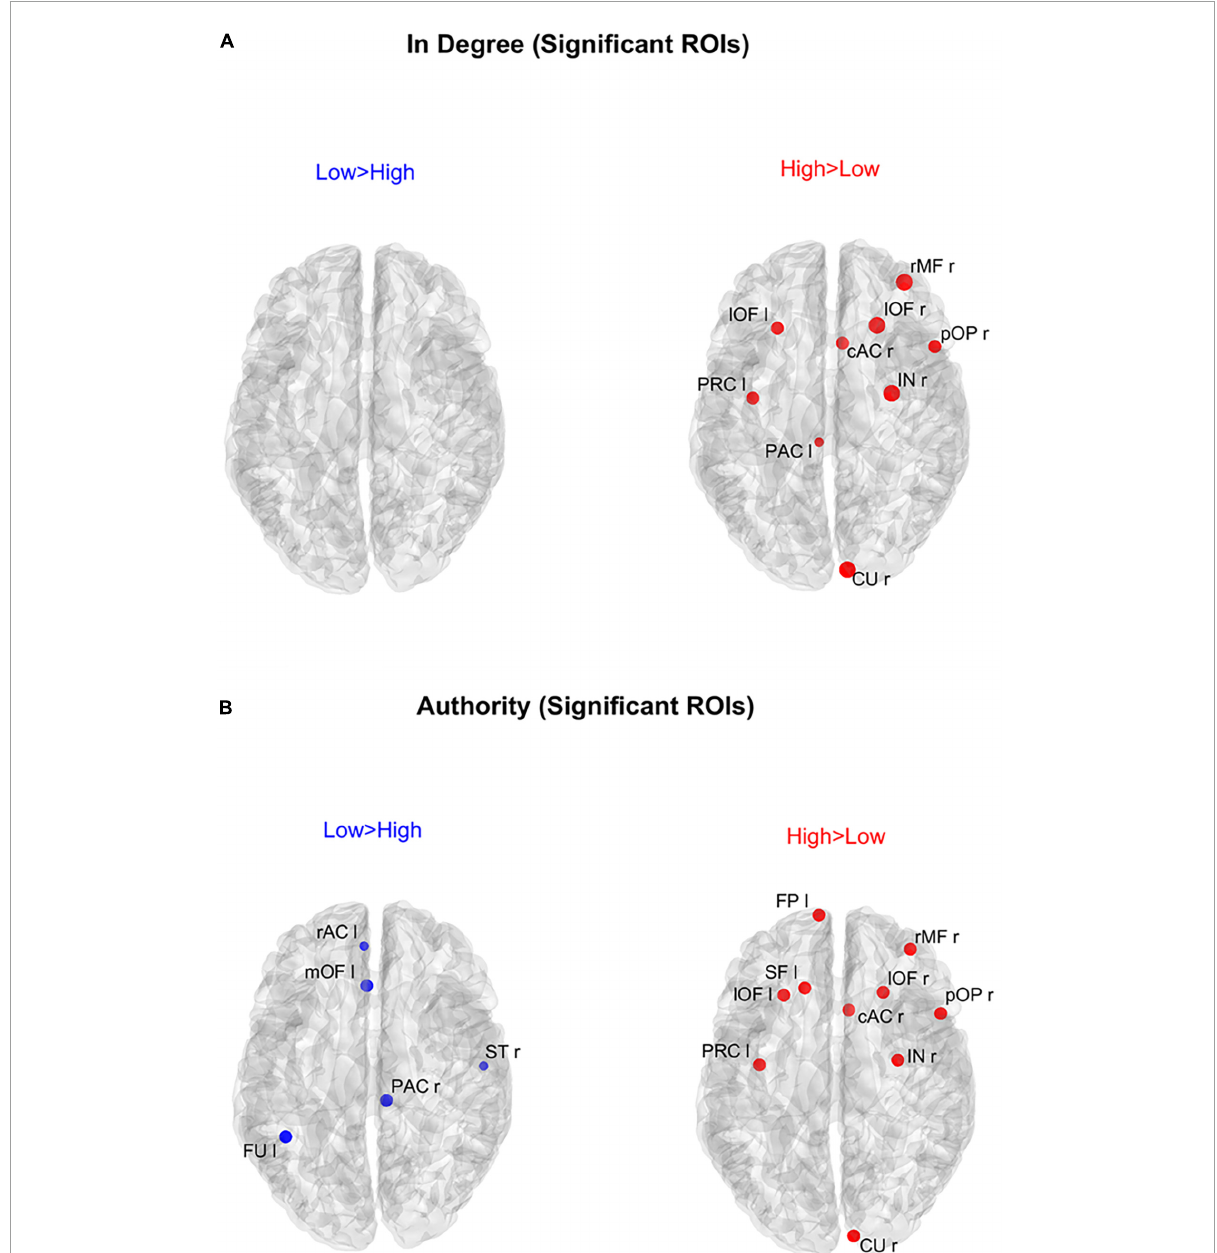
FIGURE6 Positions of the ROIs which exhibited a significant difference in the in degree index [upper panels (A) ] or in the authority index [lower panels (B) ] between the two groups ( p -value < 0.05, Bonferroni corrected). The left panels in blue (Low > High) display the ROIs having significantly higher centrality index in the Low AQ score Group compared to the High AQ score Group. The right panels in red (High > Low) display the ROIs having significantly higher centrality index in the High AQ score Group compared to the Low AQ score Group. The significant ROIs are shown as simple dots and represent regions to which important information enters. Three levels of dots’ size have been adopted: the larger the dot size, the more significant the centrality difference. For the panels where no dot appears over the brain map (i.e., in degree for Low > High), the constraint of significance was not satisfied by any of the 68